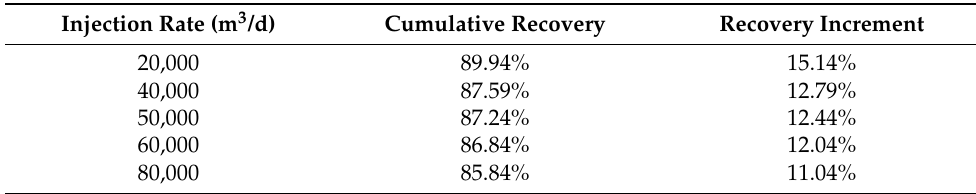
Table 2. Recovery increment under different injection rates.